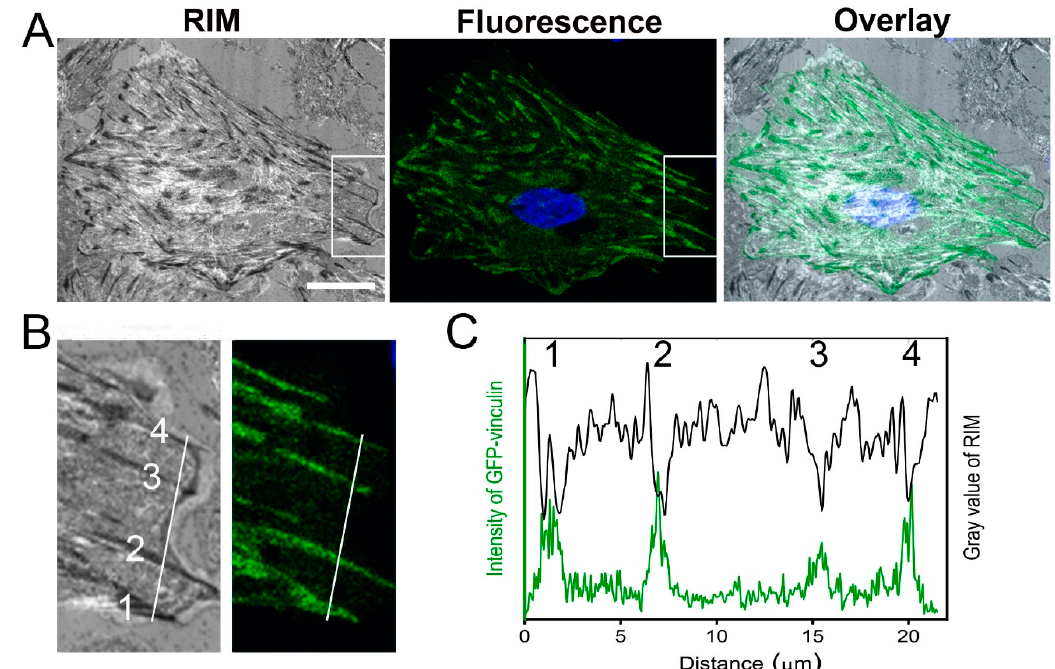
Figure 1. Identification of focal adhesion sites. ( A ) Localization of focal adhesions (FAs) of cardiac myofibroblasts using reflection interference microscopy (RIM) (left) and fluorescence microscopy (middle, green fluorescent protein (GFP)-vinculin–green, NucBlue–blue). The dark spots in reflection and the intense fluorescent spots of GFP-vinculin are widely co-localized (overlay is shown on the right). Scale bar, 20 µm. ( B ) Detail of marked areas in ( A ) and ( C ) overlay of intensity profiles of FAs (1–4) along marked line.